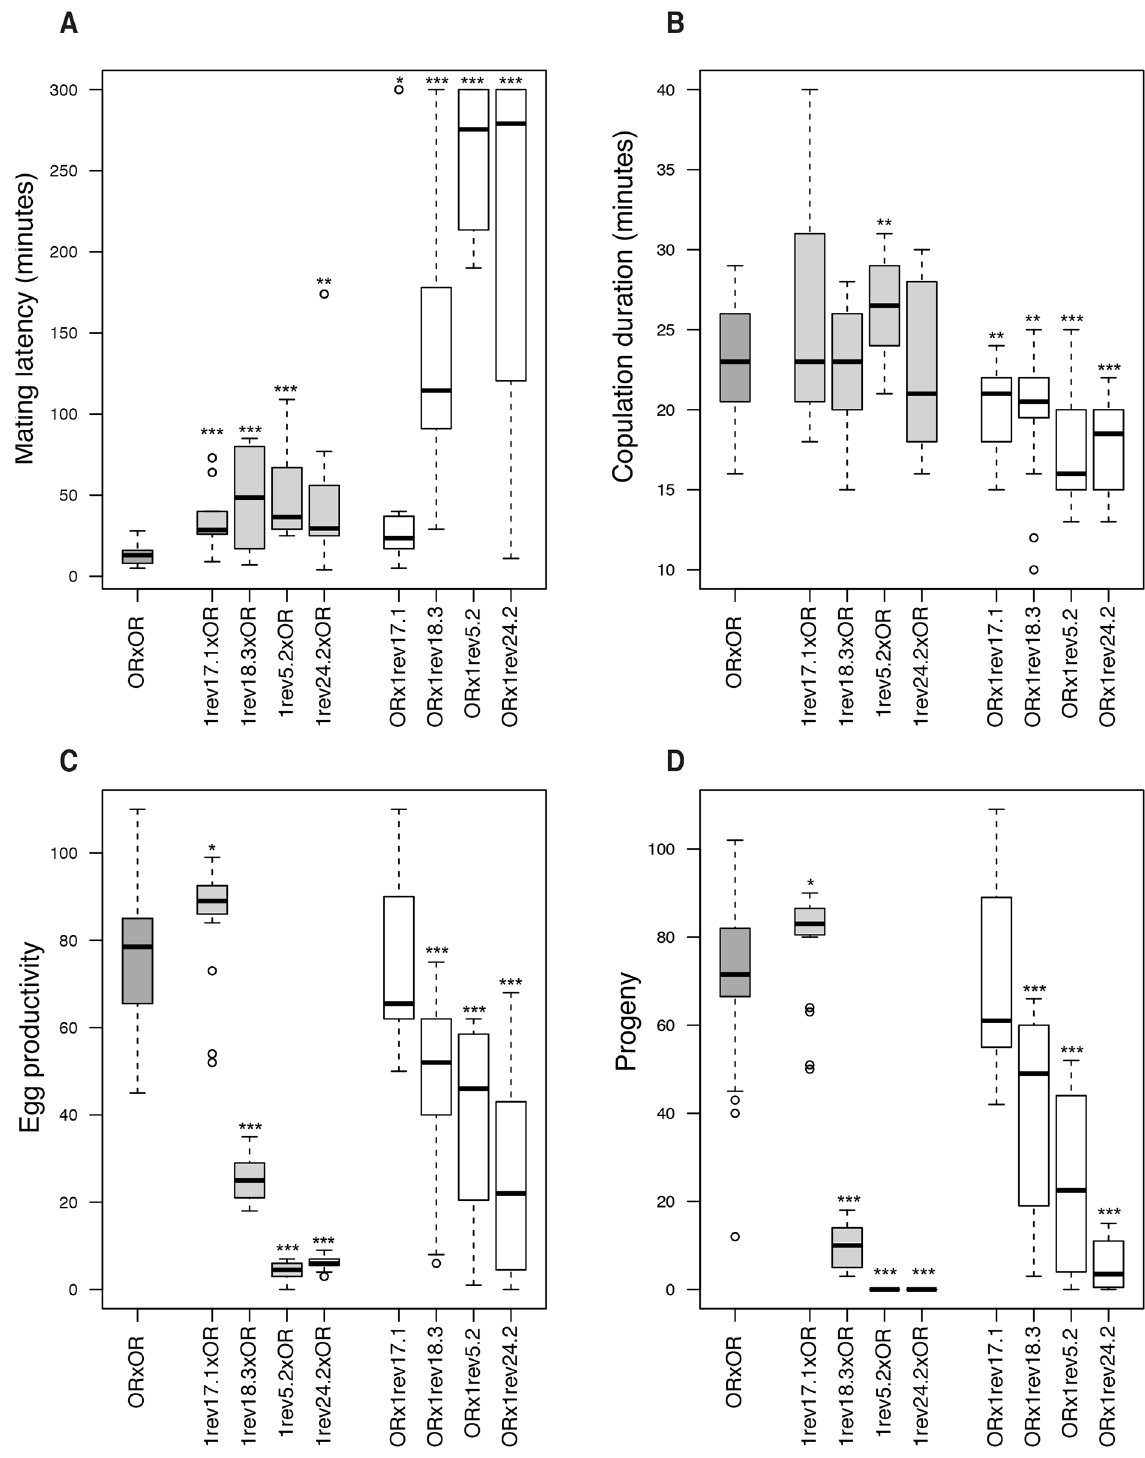
Fig 4. Mating and fertility analyses of trans-heterozygotes for ATPsynC 2 revertant alleles. Mating latency (A), copulation duration (B), egg productivity (C) and progeny (D) in single crosses between wild-type Oregon-R (OR) flies and trans-heterozygotes for ATPsynC 2 revertant alleles. By convention, each cross reads as female genotype X male genotype. “1revX.X” reads as ATPsynC 1revX . X /ATPsynC 2 . Statistical significance codes (comparison to wild-type): (cid:3) P < 0.05; (cid:3)(cid:3) P < 0.01; (cid:3)(cid:3)(cid:3) P < 0.001.